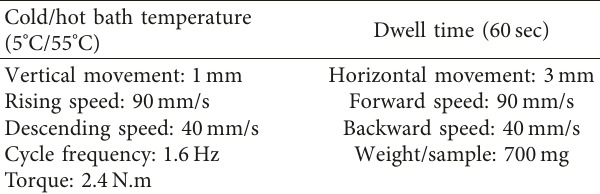
Table 3: Wear test’s